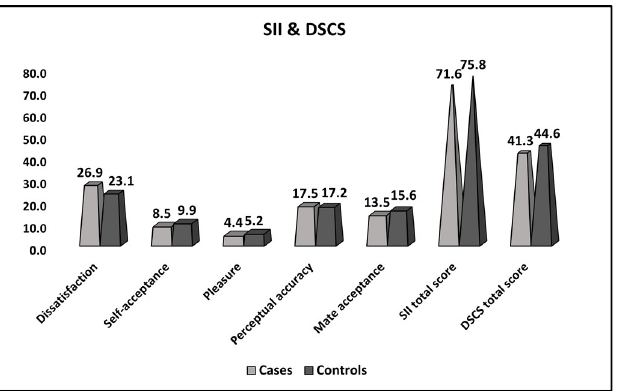
Figure 2. Comparison of SII and DSCS survey results between women with thrombophilia and recurrent pregnancy loss (cases), women with thrombophilia and recurrent pregnancy loss who achieved a normal pregnancy, and preterm or full-term birth (controls).